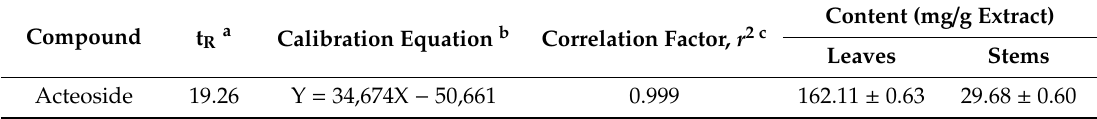
Table 3. Calibration curve and content of